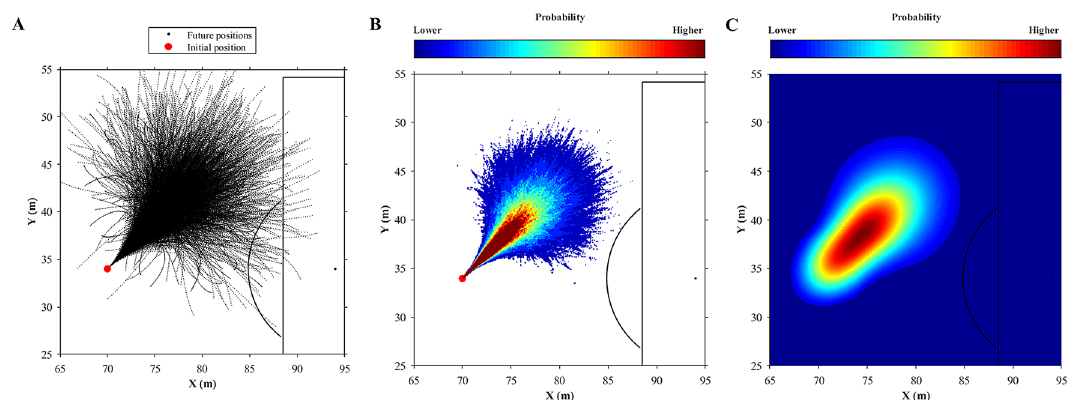
Figure 5. Example of movement model with velocity from 5 to 6 m/s, acceleration from 2 to 3 m/s 2 , and three-seconds future time window rotated and translated to player’s actual displacement at instant time (A) , probabilities of the player achieving any region in the pitch calculated from this movement model (B) , and probability model after smoothing process (C)